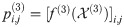
Multiview learning deciphers mechanisms across functional omics.Molecular mechanisms (Center) are resulted from the interactions within and across multiomics, e.g., shown by green, orange, and blue color. The interactions within each omics are illustrated by colored links that matches with the color of that omics; the interactions across different omics are demonstrated by black links. Directed edges represent causal relationships. Edge weights represent relationship strengths. The single-view learning methods (Right) can only learn the within-view interactions separately for each omics via the functions f(k),k = 1,2,3 (e.g., pi,j(3)=[f(3)(X(3))]i,j). The multiview learning methods (Left) can reveal the cross-talk patterns among various omics, providing complete mechanistic insights on biological functions, e.g., by co-regularization terms Ωco. These cross-talk patterns are contributed by each facet of learning in either alignment-based methods or factorization-based methods. For example, gene regulatory mechanism can relate to genomics (e.g., regulatory variants), transcriptomics (e.g., gene expression), and proteomics (e.g., TFs). Then Ωco(f(2),f(3)) represents that variants (e.g., SNPs) break the TFBSs (e.g., pi,j(2,3)=[Ωco(f(2)(X(2)),f(3)(X(3)))]i,j as in the figure). Ωco(f(1),f(3)) represents that variants affect gene expression (e.g., eQTLs). Ωco(f(1),f(2)) represents that TFs control target gene expression. The multiview learning can thus predict gene regulatory mechanisms across omics on how variants break TFBSs to affect gene expression. eQTL, expression quantitative trait loci; SNP, single-nucleotide polymorphism; TF, transcription factor; TFB, transcription factor binding site.